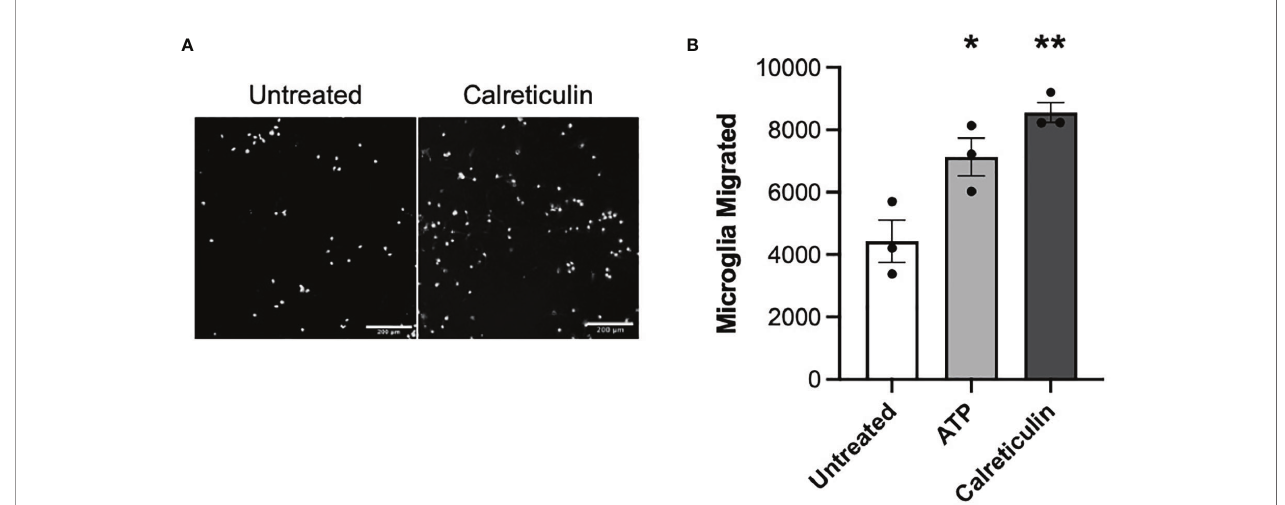
FIGURE 4 | Microglia migrate towards calreticulin. (A) Representative images and (B) quanti fi ed migration of BV-2 microglia migration across a transwell towards 17 nM calreticulin over 24 hours. 10 µM adenosine triphosphate (ATP) acted as the positive control. Microglia were stained with Hoechst 33342. Scale bar = 200 µm. Data presented as mean microglial migration values, with error bars representing the SEM of 3 independent experiments. Statistical comparisons were made to the untreated control by one-way ANOVA. *p<0.05, **p<0.01.